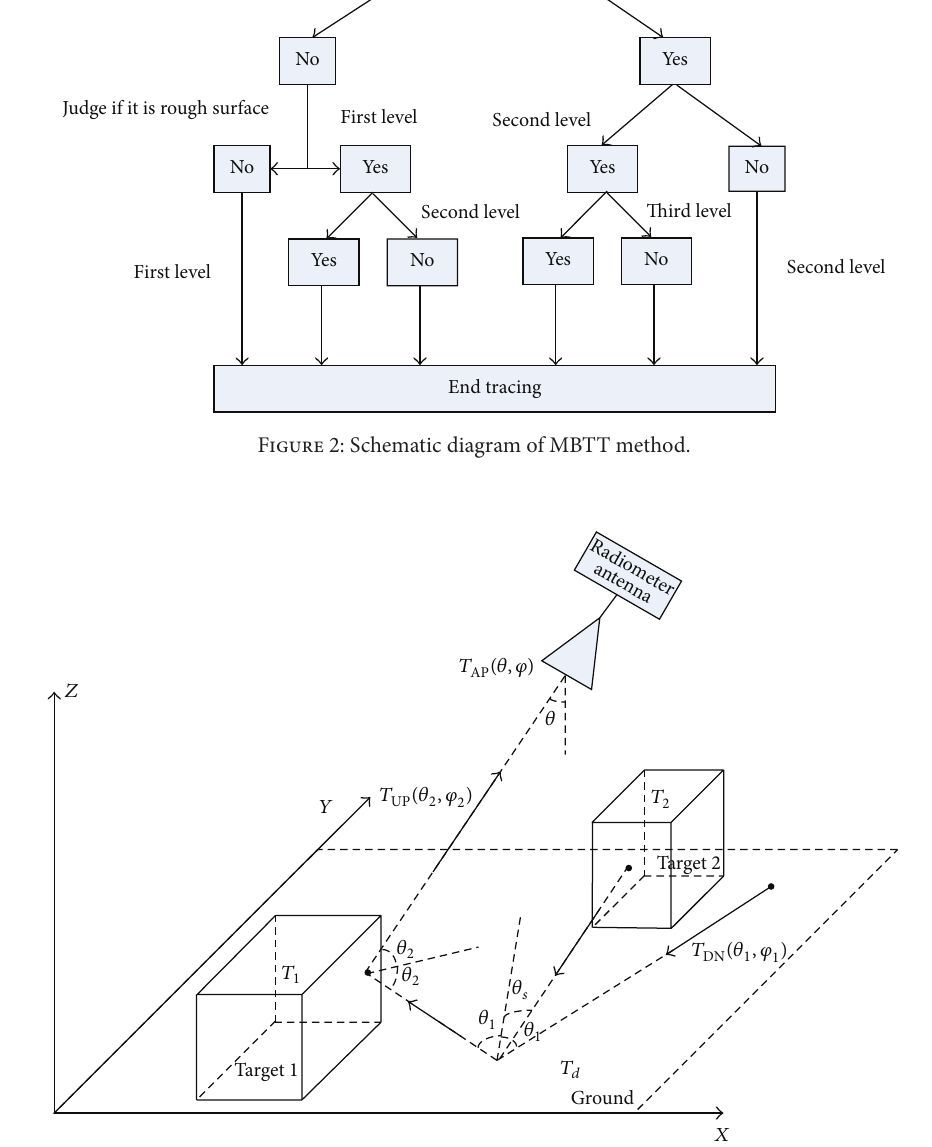
Figure 3: Physical model of space to